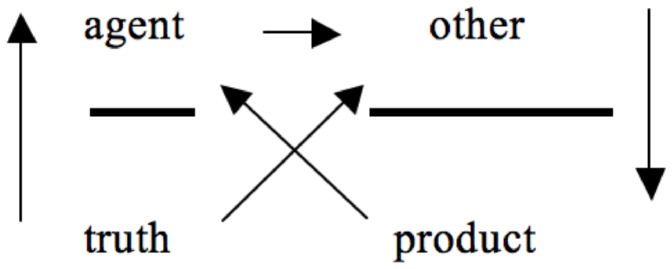
The overall structure of the discourses and the relations between all positions (based on Lacan, 1969–1970, p. 93, 196; Lacan, 1972, p. 40).